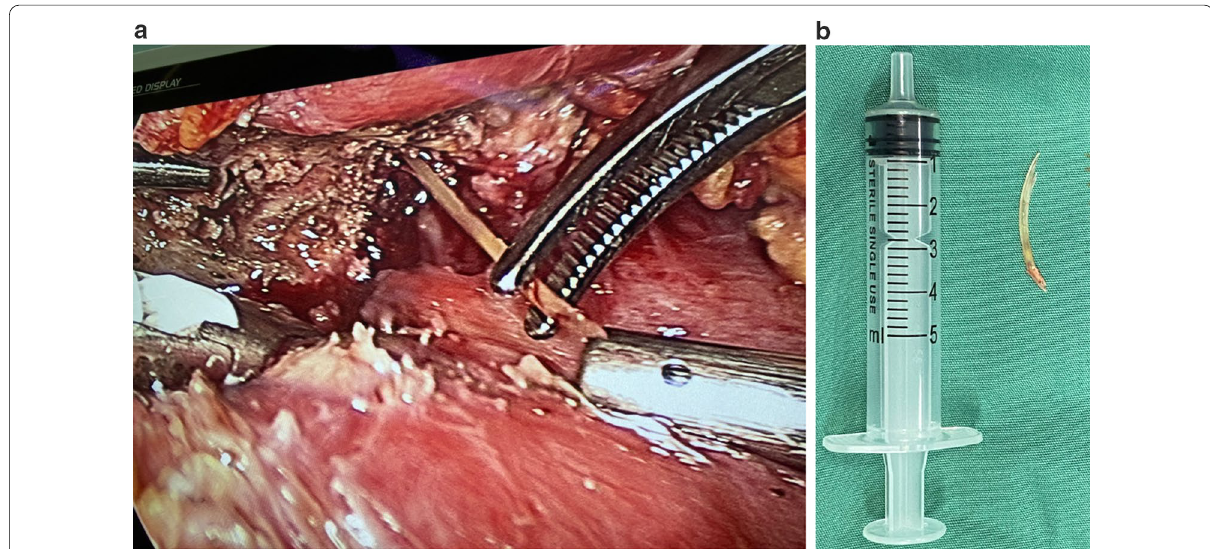
Fig. 2 a A linear foreign body was found between the prepyloric region of the stomach and the pancreatic neck and was safely removed from both pancreas and stomach laparoscopically. b The foreign body was identified as a 3.2-cm-long fish bone after removal